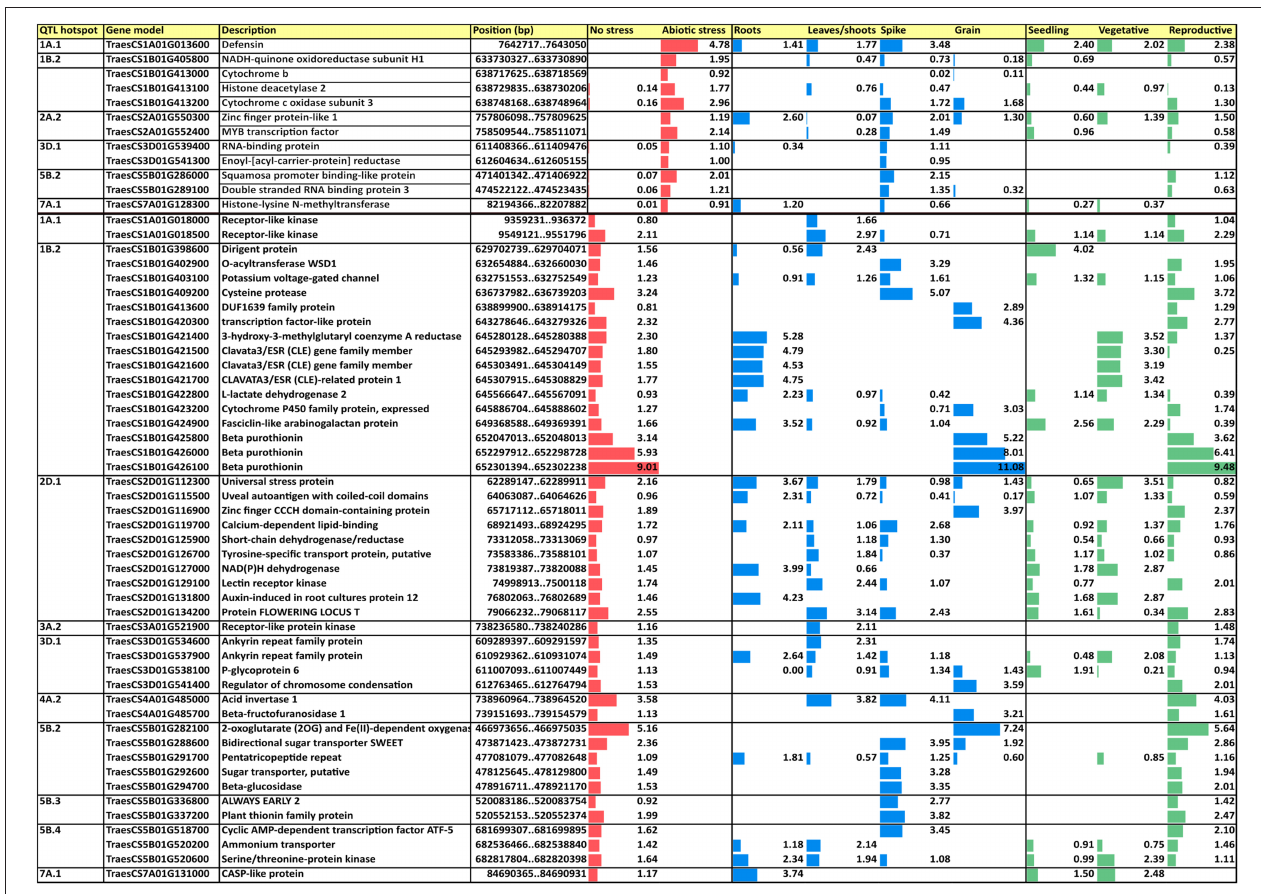
FIGURE 7 | Upregulated and downregulated CGs under abiotic stress conditions in four tissues and three developmental phases. Values are based on log 2 tpm. CGs, candidate genes; tpm, transcripts per million.